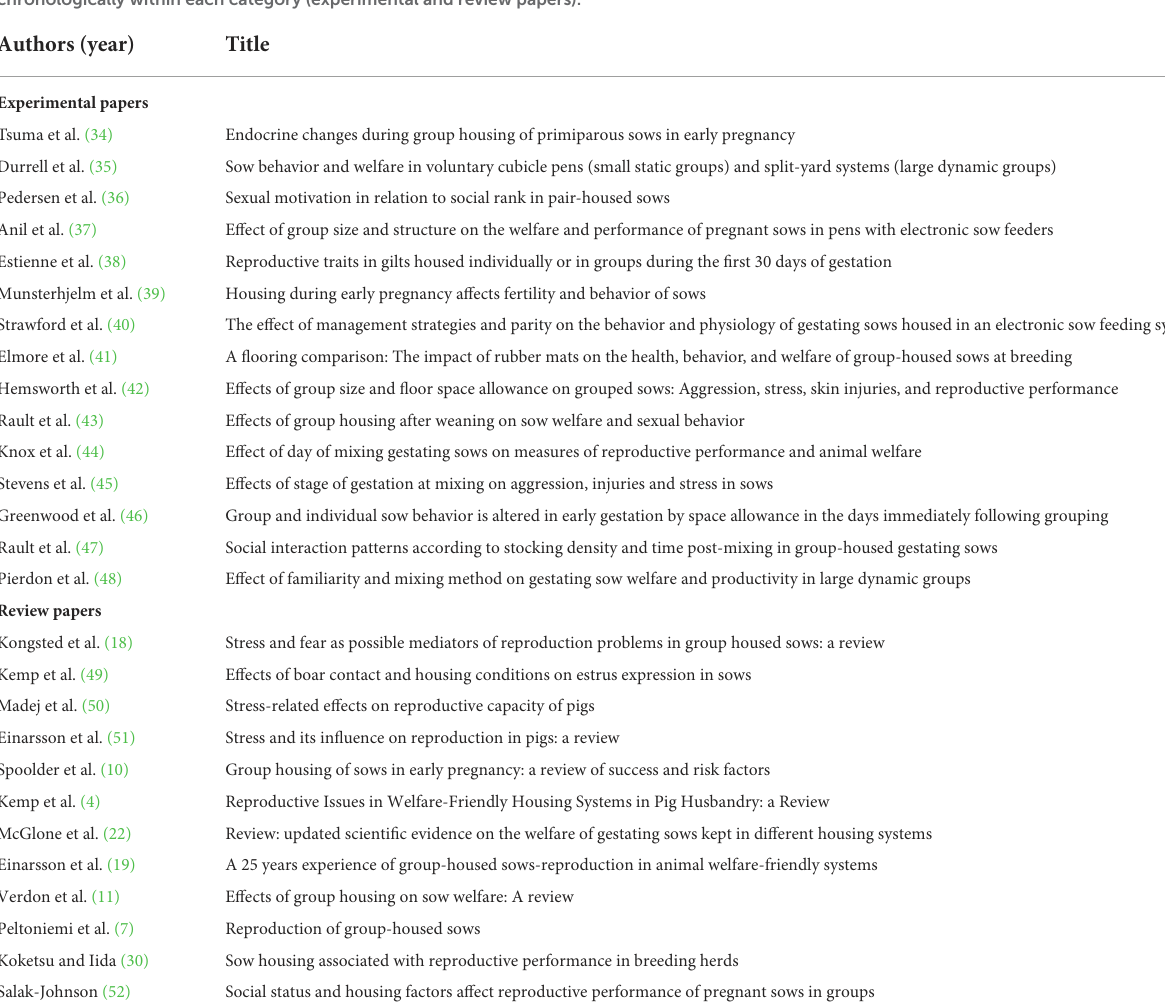
TABLE 2 List of literature ( n = 27) which covers the topic of sow housing and welfare during post-weaning and early pregnancy, sorted chronologically within each category (experimental and review